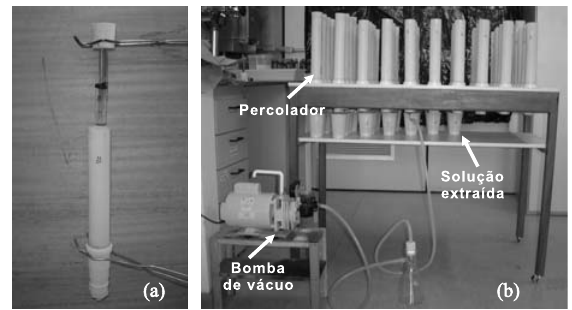
Figura 1. Imagem aproximada de um dos percoladores com recipiente de vidro acoplado à rolha de borracha por meio de haste plástica (a) e mesa com as colunas de percolação - , por colorimetria, por meio de sistema de de N-NO 3 fluxo contínuo (FIA) (Giné et al., 1980; Alves et al.,